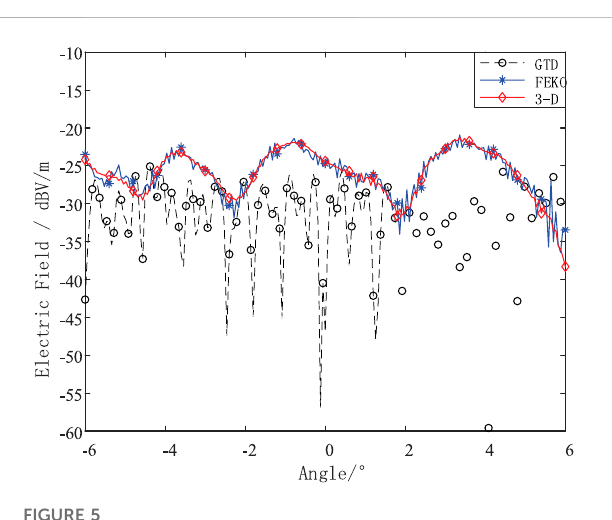
FIGURE 6 Distribution of scattered electric fi eld error